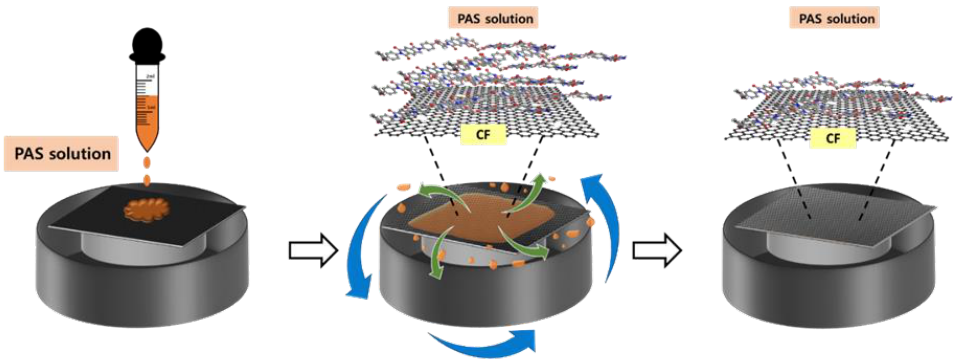
Figure 2. Schematic diagram of the process for surface treatment of carbon fibers using the PAS solution.